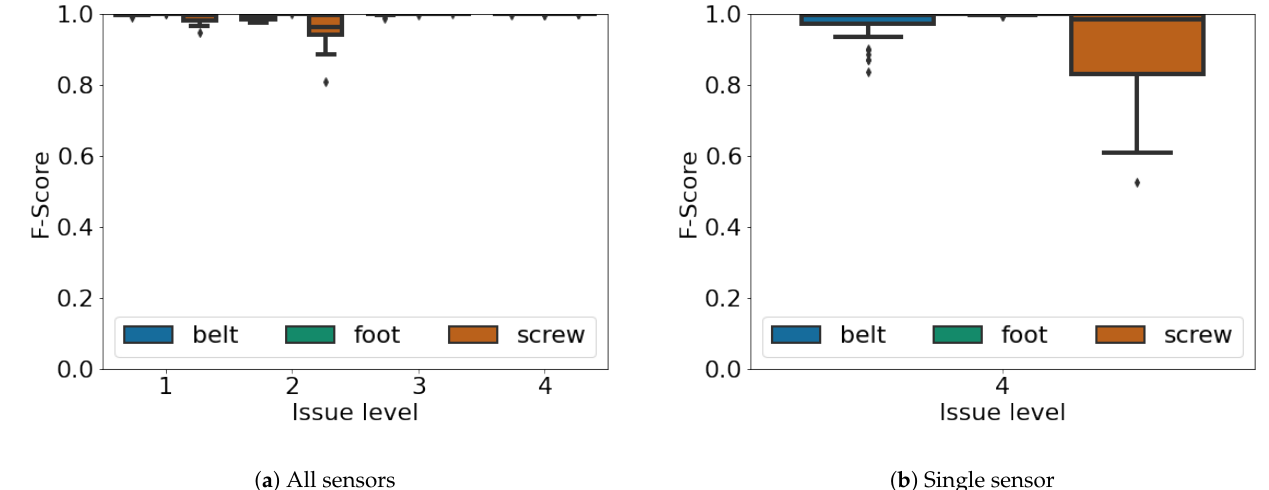
Figure 8. F-score of the classifier among different issues and different issue levels.